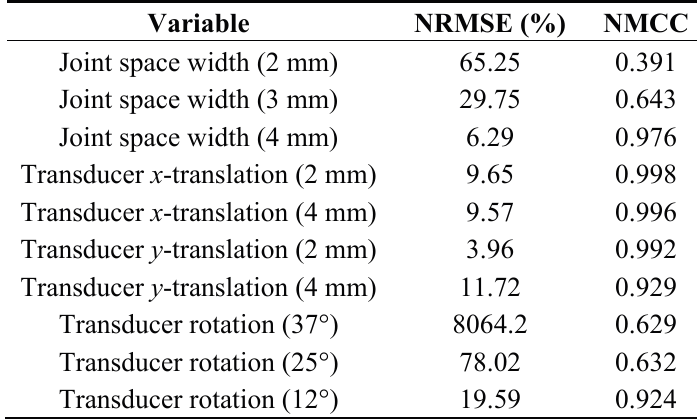
Table 2. Normalized root mean square error (NRMSE) and normalized maximum cross correlation (NMCC) for parametric models simulating the parameters related to the ankle joint ( i.e. , joint space width) and to the US transducers ( i.e. , translation and rotation of US transducer acting as transmitter). In each parametric simulation, only one parameter of the model was changed, and the other parameters were kept identical to those of the reference